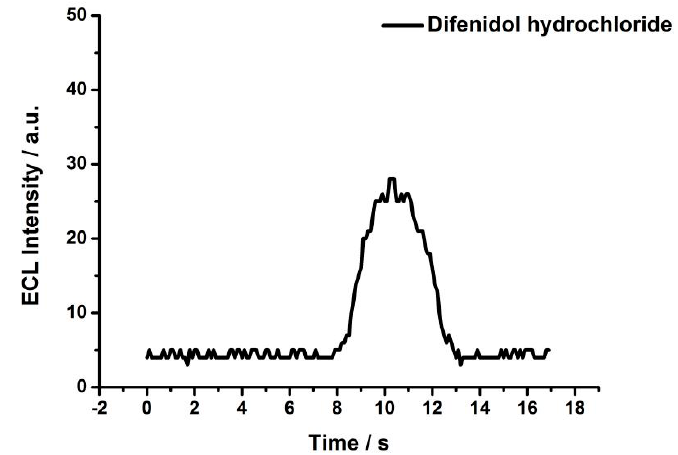
Figure 3. ECL intensity–time curve of difenidol hydrochloride in a solution with 3 × 10 − 5 mol·L − 1 of difenidol and 0.1 mol·L − 1 of BBS (pH 7.5).